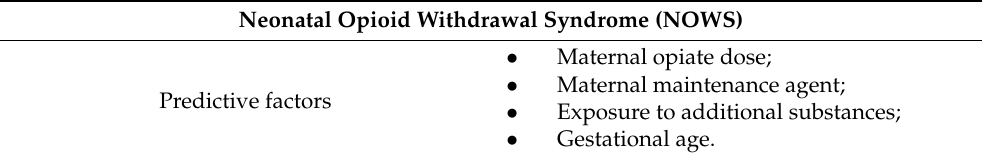
Table 4. A summary of the key points for the identification of